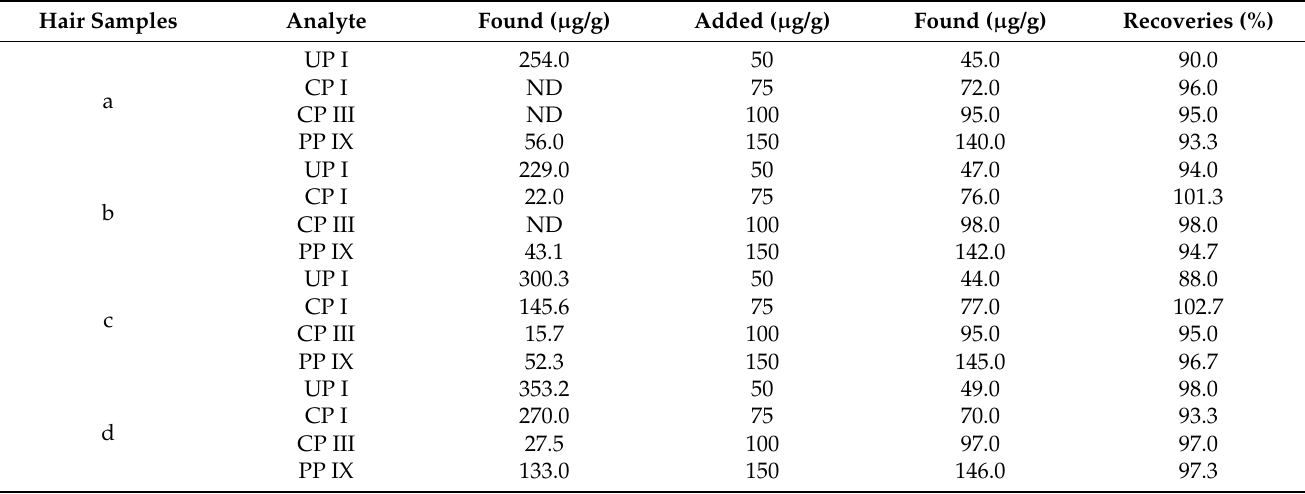
Table 4. Porphyrin concentrations in extracts of Southern flying squirrel hair.